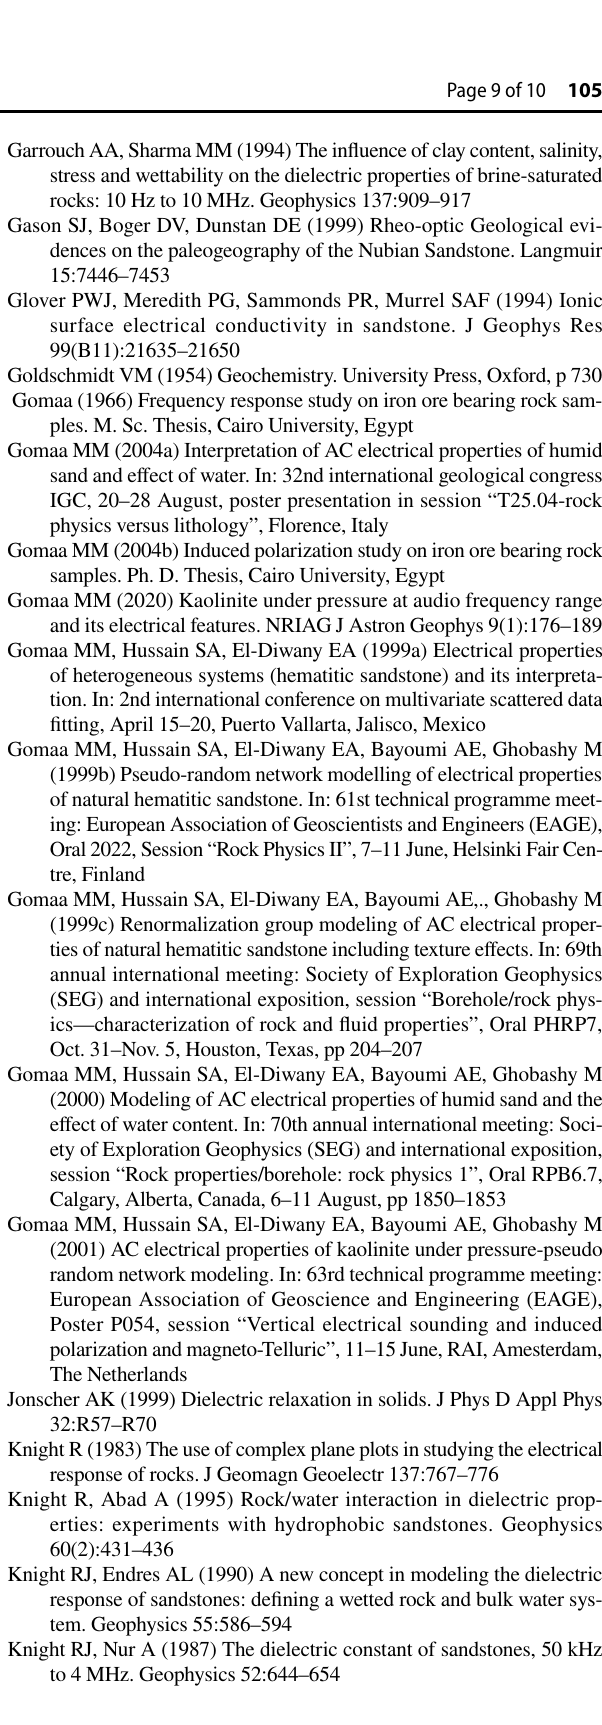
Fig. 5 a Variation of the complex impedance with frequency for Aswan iron ore deposits, for samples 1 ( ) , 2 ( ) , 3 ( ) , 4 ( ) and 5 ( ) , respectively. b Variation of the complex impedance with fre- quency for Aswan iron ore deposits, for samples 2 ( ) , 3 ( ) , 4 ( ) and 5 ( ) ,